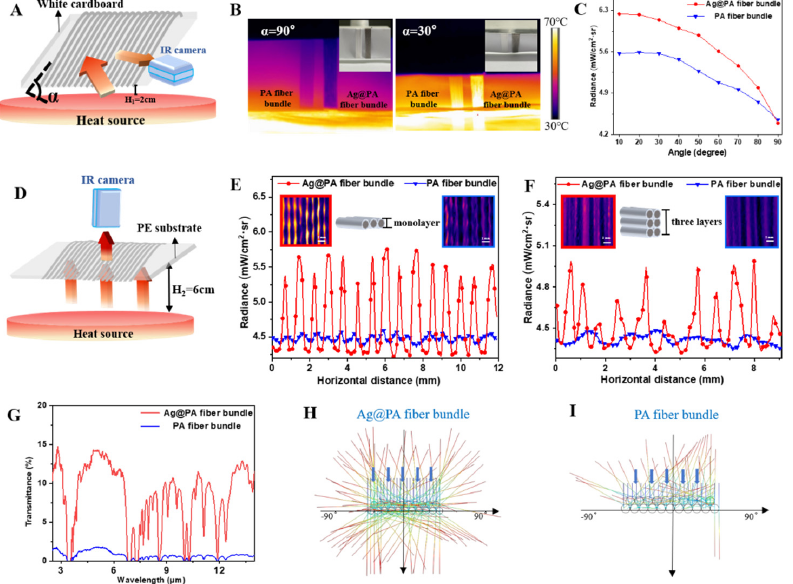
Figure 2. ( A ) Schematic diagram of infrared energy reflection test of fiber bundle; ( B ) thermal images of PA bundle and Ag@PA bundle at 90° (left) and 30° (right) between bundle and heat source; ( C ) infrared reflected energy comparison of two fiber bundles; ( D ) schematic diagram of infrared energy transmission test of fiber bundle; ( E , F ) infrared radiation change versus location of single-layer fiber bundle ( E ) and three-layer tiled fiber bundle ( F ); ( G ) IR transmittance of Ag@PA fiber bundles and PA fiber bundles; ( H , I ) IR transmission simulation of PA fiber bundle ( H ) and Ag@PA fiber bundle ( I ).